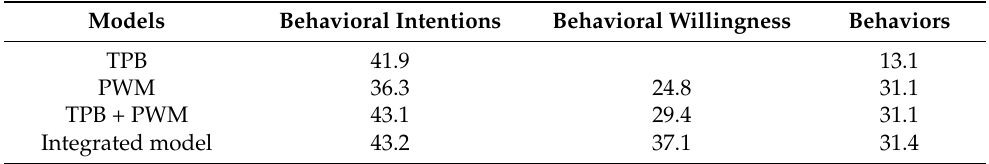
Table 4. Explanatory power for each model (%).